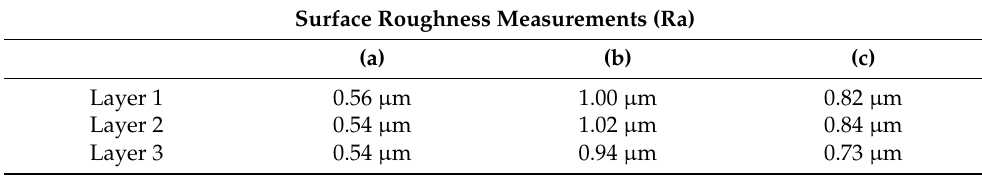
Table 3. Surface Roughness Measurements (Ra).